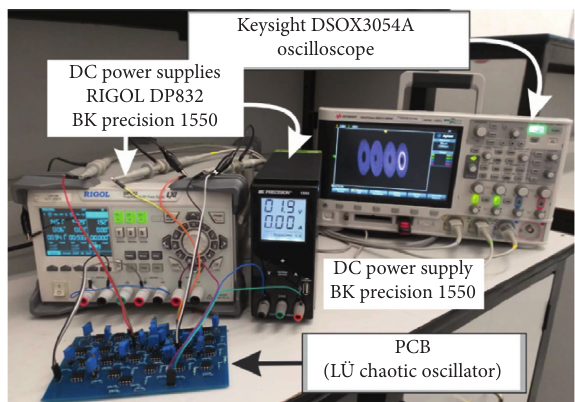
Figure 11: Experimental setup.